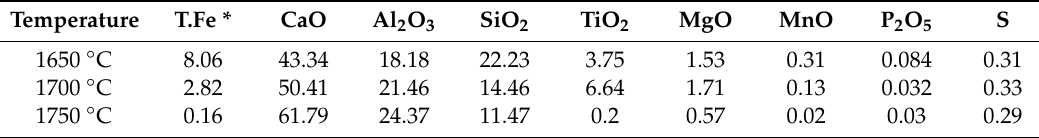
Figure 8. Samples of metal and slag obtained after reduction smelting of RM at ( a ) 1650 ◦ C, ( b ) 1700 ◦ C, and ( c ) 1750 ◦ C. Table 3. The slag chemical composition after reductive smelting of the RM (wt